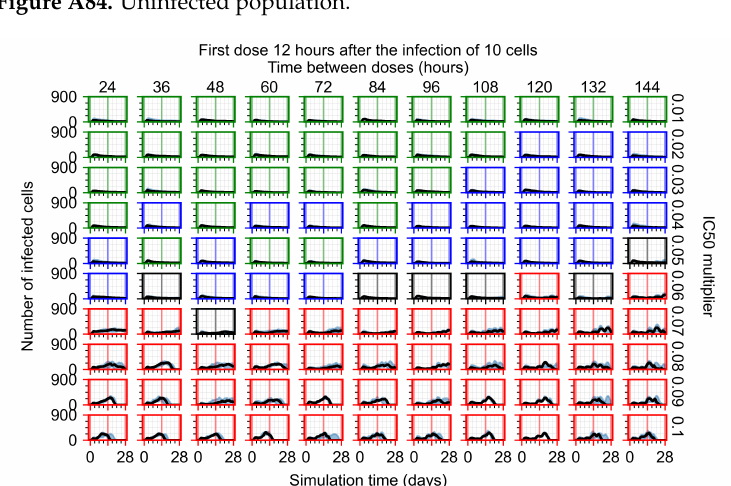
Figure A85. Infected (eclipse phase)